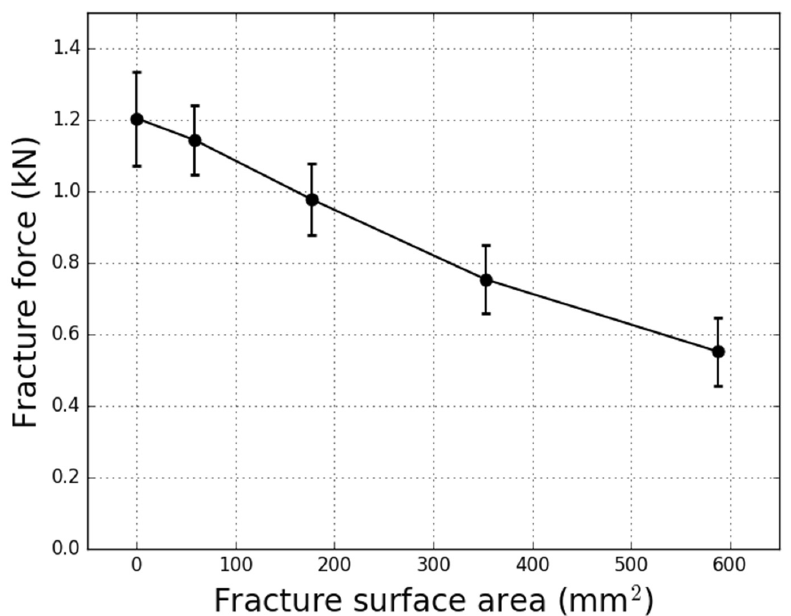
Figure 15. Effect of fracture surface area on the mean fracture force. Error bar (SD) represents the standard deviation.